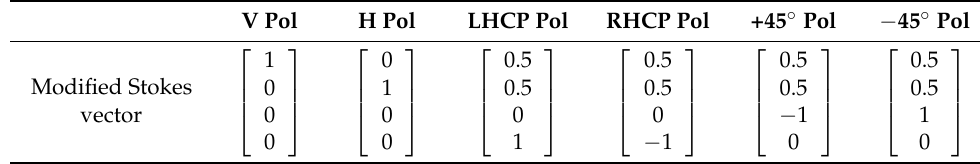
Table 1. Modified Stokes vectors for various polarizations.